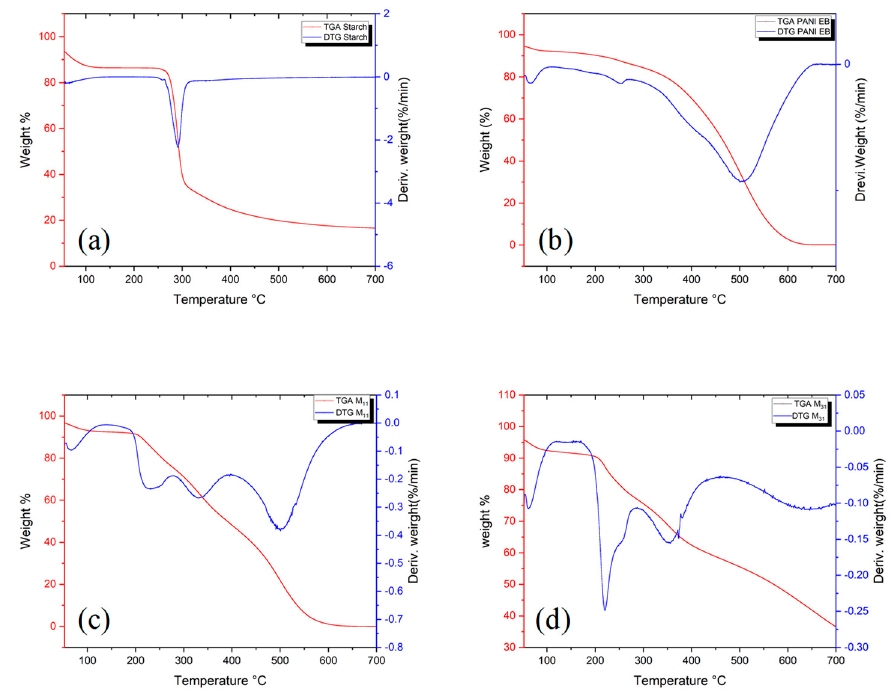
Figure 6. TGA and first derivatives curves of, ( a ): starch, ( b ): PANI EB and their biocomposites ( c ): M 11 , ( d ): M 31.